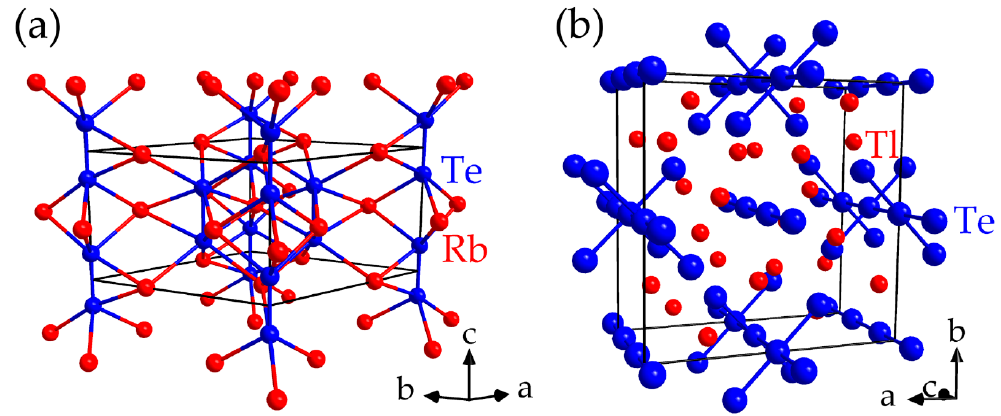
Figure 3. Representations of the crystal structures of: ( a ) Rb 2 Te 2 [80] comprising [Te 2 ] 2 − dumbbells; and ( b ) TlTe [81] composed of tellurium chains to which further tellurium atoms are attached as “handles”.